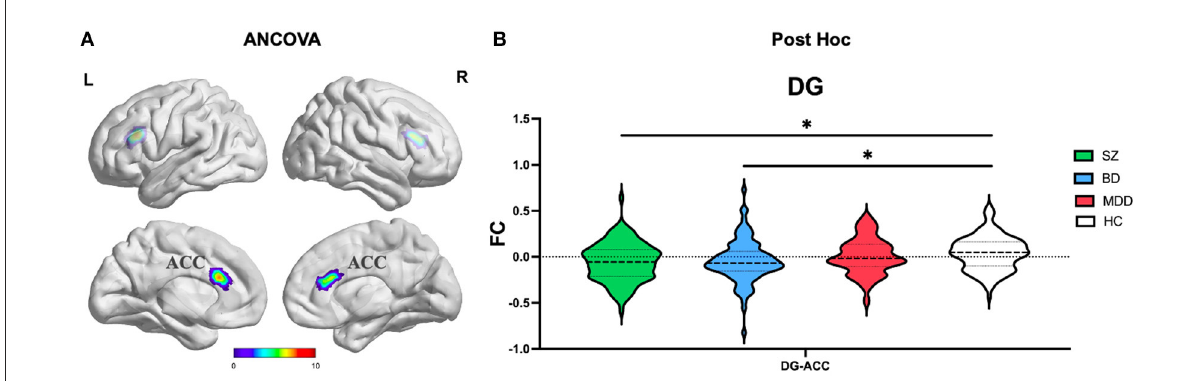
FIGURE3 The FC alterations of DG subregion analyzed by (A) ANCOVA analyzed. (B) The post hoc pair-wise t test. FC, Functional Connectivity; DG, Dentate Gyrus; ANCOVA, Analysis of Covariance; SZ, Schizophrenia; BD, Bipolar Disorder; MDD, Major Depressive Disorder; GRF, Gaussian Random Field. ANCOVA: Significance was set at cluster p < 0.05 corrected using GRF with voxel p < 0.005. Post-hoc : *Significance was set at cluster p < 0.05 corrected using GRF with voxel p < 0.001.